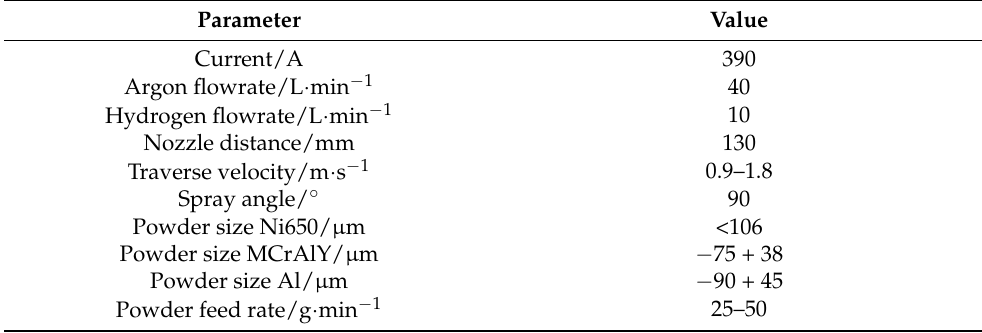
Table 2. APS process parameters (Delta torch) used in the thermal spray